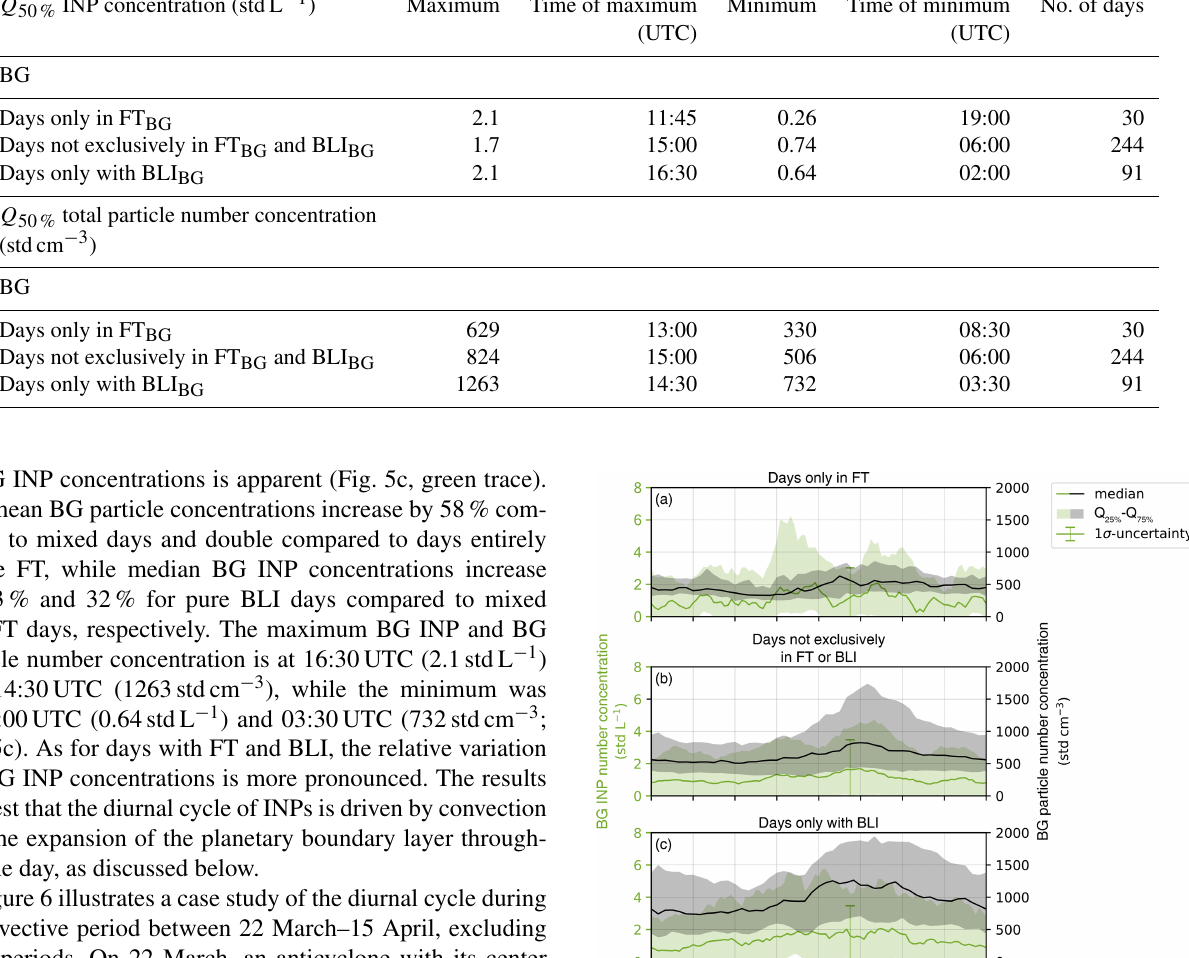
Table 2. Diurnal statistics of BG INP concentrations at T = 243.15K and S w = 1.04 and BG total particle number concentrations ( ≤ 14nm), for the median of the phase-averaged concentrations measured at JFJ between 7 February, 7 February 2020, and 31 January 2021. Q 50% INP concentration (stdL − 1 )